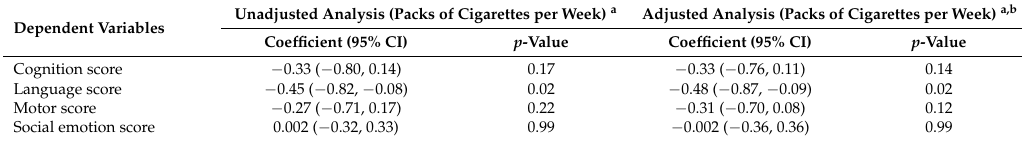
Table 4. Multivariate regression for the self-reported frequency of prenatal exposure to ETS on child development in rural Guizhou